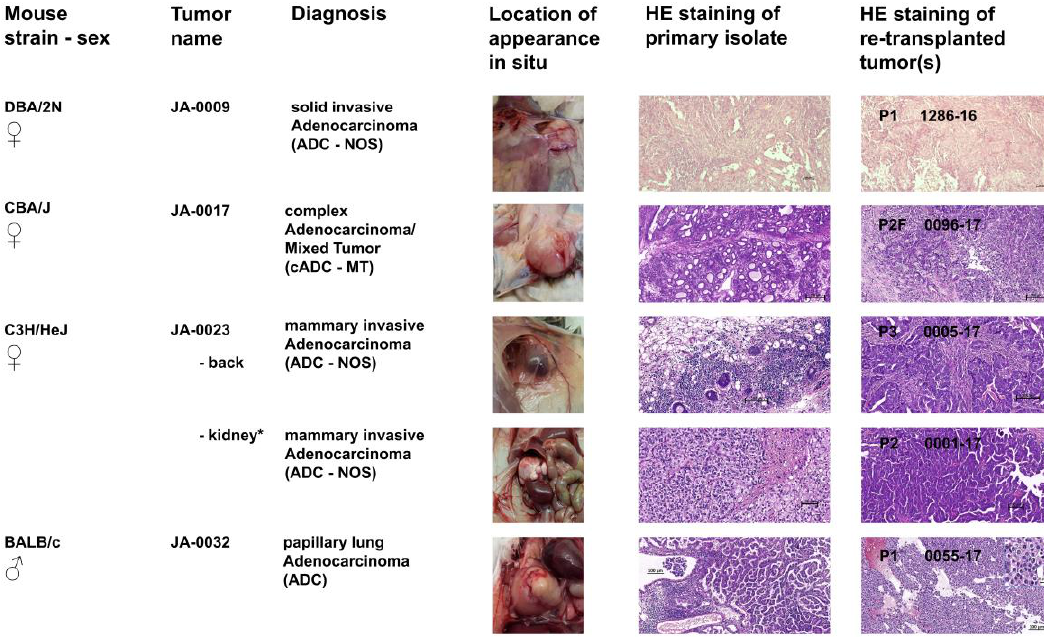
Figure 3. Histopathological characterization of four adenocarcinoma sMDI. In situ location as well as H&E staining of primary isolated tumor or suspicious tissues and of re-transplanted subcutaneous tumors (passages P1–P3), or frozen tumor tissue pieces (passage P2F) were documented by photographs for four selected non-hematopoietic tumor models (JA-0009, JA-0017, JA-0023, and JA-0032). For JA-0023, two malignant primary tissues were isolated from the back and kidney. Original diagnosis of kidney tumor was a clear cell-like renal adenocarcinoma. Re-transplanted kidney tumors (e.g., 0001-17), however, displayed the same histology as the primary back tumor of mammary invasive ADC. For more details see: Doc. S1-sMDI.